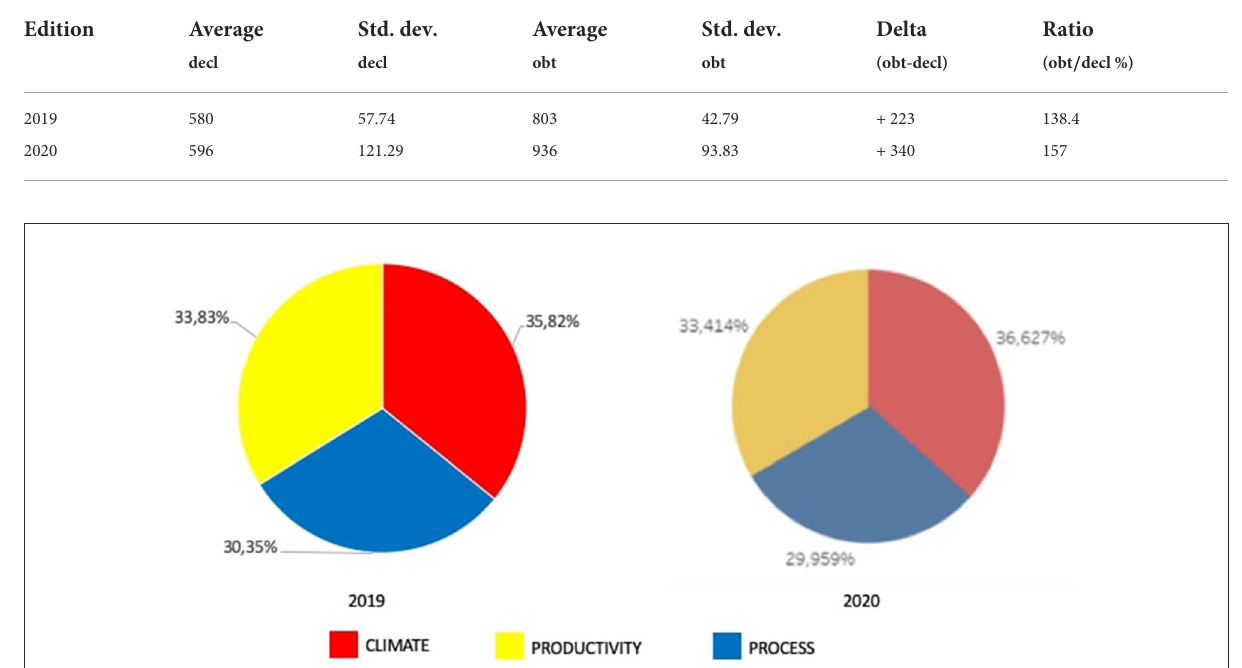
FIGURE7 Climate, productivity, and process dimensions in teams, according to the peer evaluation questionnaire, in the two